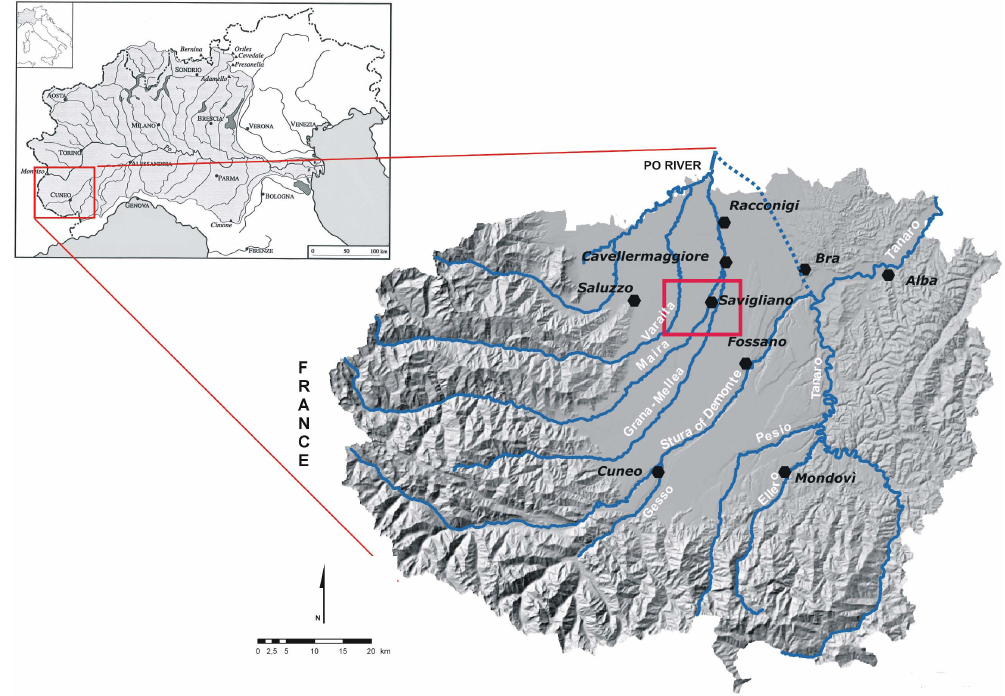
Fig. 1. The Cuneo plain with the main hydrographic network, the main cities and studied area (red square). The blue dotted line north of the city of Bra indicates the old path of the Tanaro River. In the background, the Regione Piemonte DTM hillshade, with NW artificial azimuth direction (ESRI ArcGIS 9.2 processing, grid 50 ×